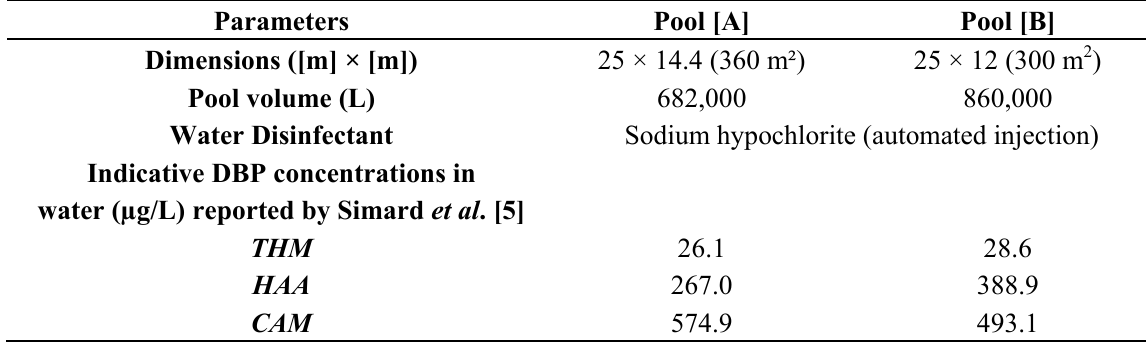
Table 1. Technical information on configuration and water treatment in each studied swimming